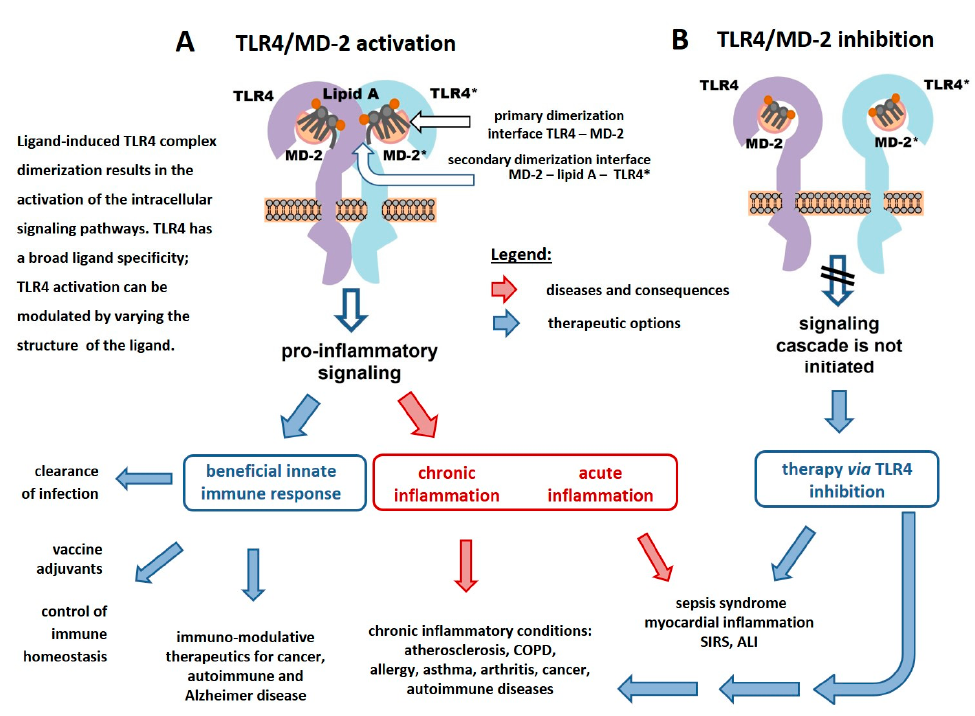
Figure 2. Schematic representation of lipid A-induced activation ( A ) and inhibition ( B ) of the TLR4/MD-2 complex and the options for therapeutic modulation of TLR4-mediated signaling.